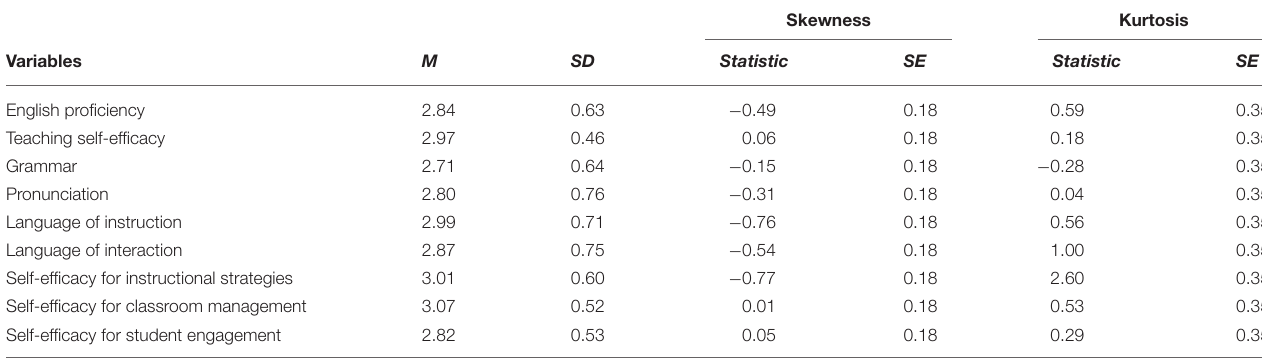
TABLE 1 | Descriptive statistics for English proficiency, teaching self-efficacy, and their constructs (means, standard deviation, skewness, and